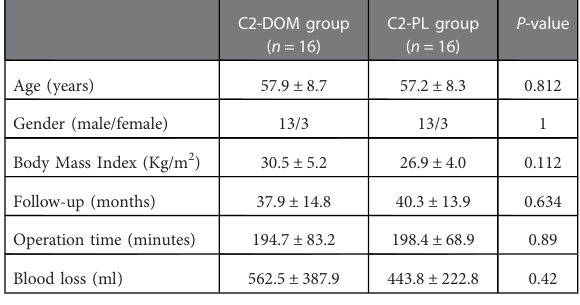
TABLE 1 Comparison of patient characteristics between C2-DOM group and C2-PL